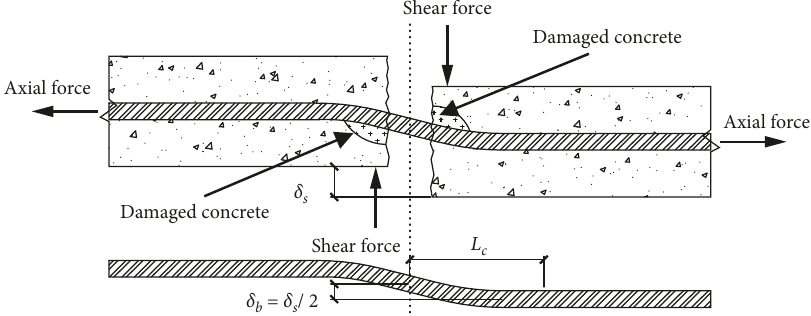
Figure 10: The steel bar dowel shear reaction at joint interface.